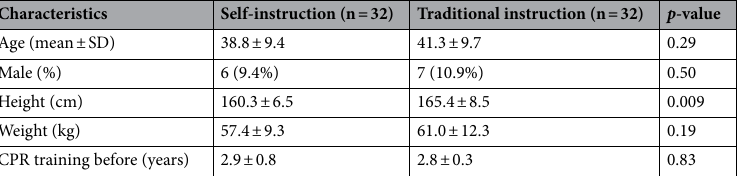
Table 1. The characteristics of participants between two groups. SD, standard deviation; CPR, cardiopulmonary